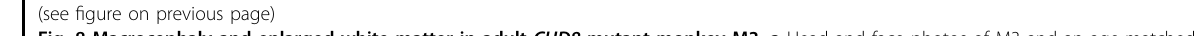
Fig. 8 Macrocephaly and enlarged white matter in adult CHD8 mutant monkey M3. a Head and face photos of M3 and an age-matched control monkey at 54 months. b Skeleton head images of M3 and control monkey. The sizes (height and width) of the head are indicated by red lines. Scale bar: 1 cm. c Head circumference (cm) and total brain volume (mm 3 ) of M3 and 15 age-matched male control monkeys at 36 months. d Sagittal MRI images of M3 and a control monkey. The red lines indicate the same location and orientation of the slices that were used to obtain coronal MRI images containing the cerebral cortex. e Horizontal MRI images of M3 and control monkey showing white matter that appears whiter and gray matter that is darker. Scale bar: 5 cm. The coronal images were obtained from the respective brain slices shown in ( d ). The enlarged images in the dashed square are shown beneath each coronal image. M3 brain shows enlarged white matter in several lobes shown. f Quantitation of the volume of white matter and the ratio of white matter to gray matter. Controls consist of three age-matched monkeys. The data are presented as means ±